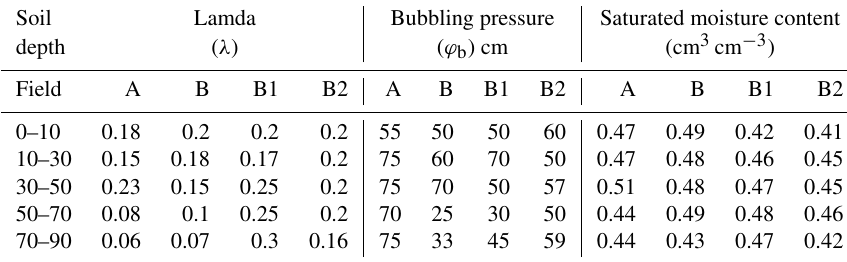
Table 5. Fitted Brooks–Corey parameters for the soil moisture characteristic curve. Soil Lamda Bubbling pressure Saturated moisture content depth